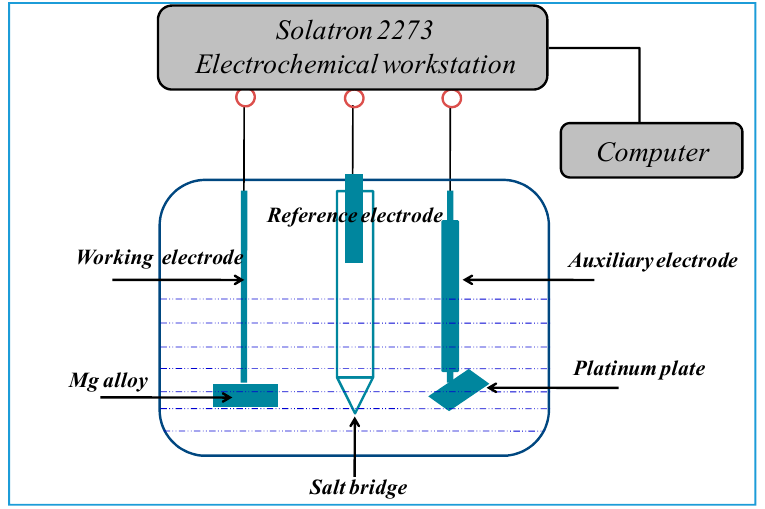
Figure 2. Schematic of the electrochemical testing of magnesium alloys in NaCl solution.